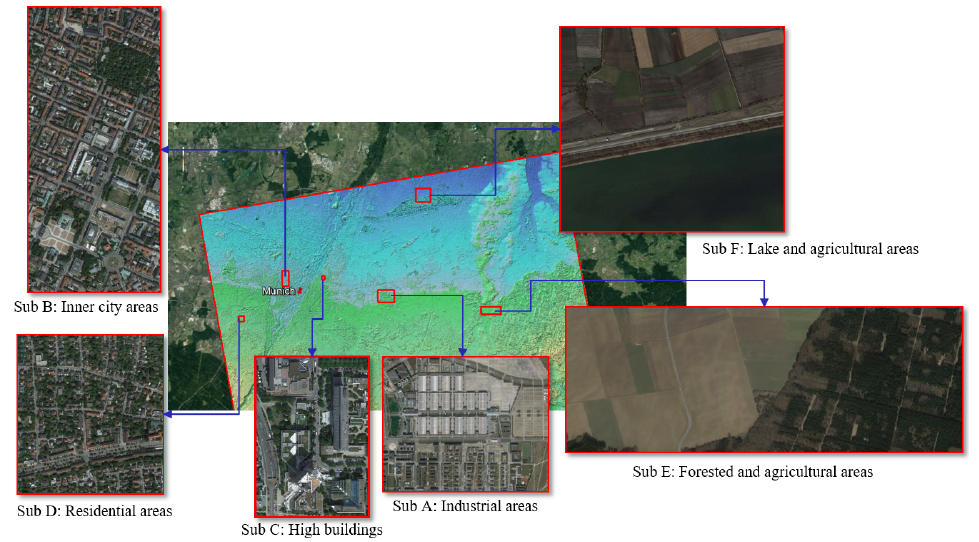
Figure 2. Depictions and locations of study